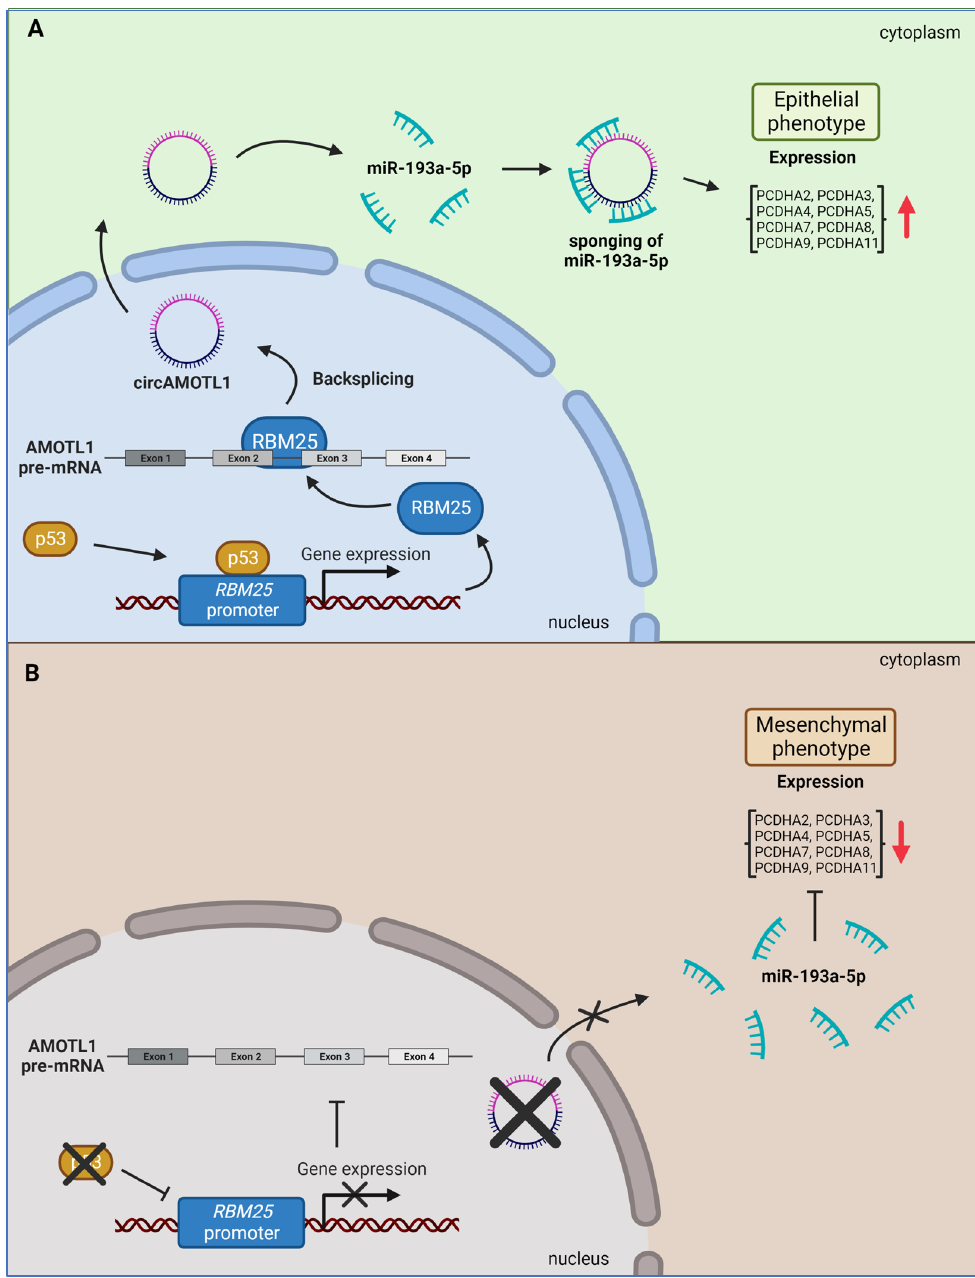
Figure 6. In prostate cancer, metastatic epithelial cells need to undergo an epithelial-to-mesenchymal transition. ( A ) In healthy epithelial cells, the p53 protein promotes the expression of RBM25 RNA-binding protein, which facilitates the formation of circAMOTL1. After translocation to the cytoplasm, circAMOTL1 binds and sequesters miR-193a-5p, acting as a cytoplasmic miRNA sponge. Sponging of miR-193a-5p by circAMOTL1 protects mRNAs of the protocadherin family from miRNA-dependent degradation. This process leads to increased protocadherin production and preserves the epithelial character of enterocytes. ( B ) In primary prostate cancer cells, p53 is either lost or mutated, which inhibits the expression of RBM25. Loss of RBM25 decreases the production of circAMOTL1. In the absence of circAMOTL1, miR-193a-5b targets PCDHA family mRNAs and reduces cellular adhesion. At the same time, increased vimentin and β -catenin expression promotes cell migration and EMT.